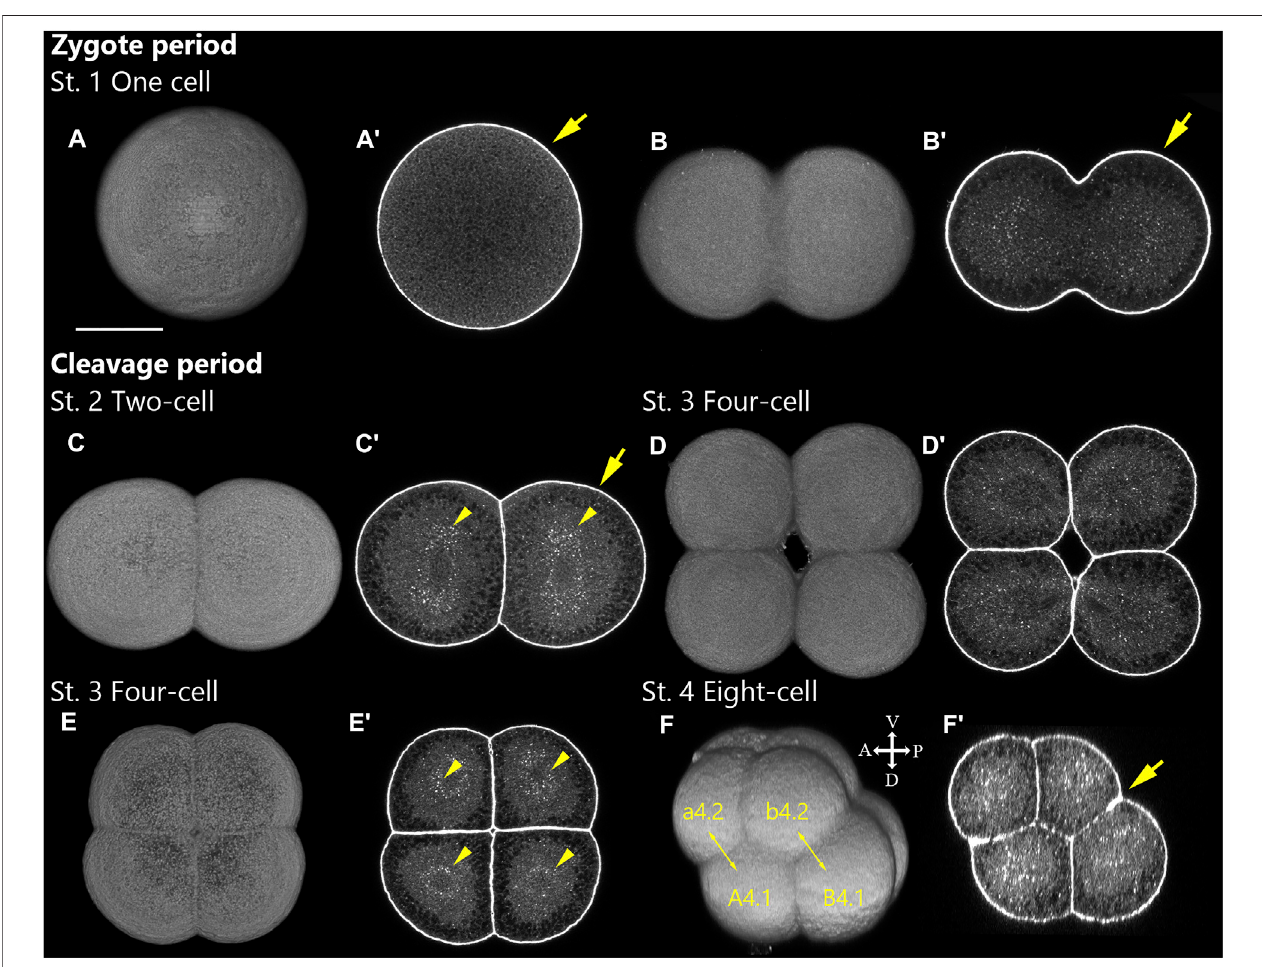
FIGURE2| Ascidiellaaspersa embryosatzygoteandtheinitialpartofcleavageperiods.EmbryosarestainedwithAlexaFluor ™ 546Phalloidin.Three-dimensional reconstructed images at (A,B) Stage 1 (One cell), (C) Stage 2 (2-cell), (D,E) Stage 3 (4-cell), and (F) Stage 4 (8-cell). (A 9 – F 9 ) The cross-section of (A – F) , respectively. Anteriorsideofeachembryoisupunlessnotedspeciallyinthebodyaxis.In (F,F 9 ) ,embryodirectionisshownbyA,anterior;P,posterior;D,dorsal;V,ventral.Inaddition tothecorticalactin fi lamentsbeneaththecellmembranes(arrows),thestainingcoulddetectthecytosolicactin fi lamentssurroundingthenuclei(arrowheads).Two- headed arrows indicate a pair of daughter cells. The number of cell-lineages are drawn on each blastomere. Scale bar: 50 μ m.